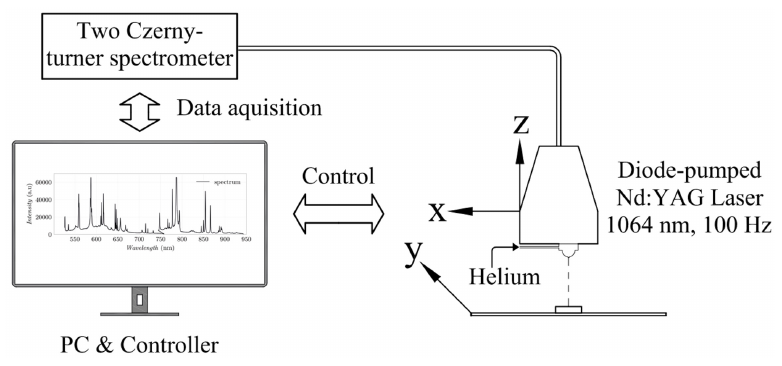
Figure 1. Schematic of LIBS general